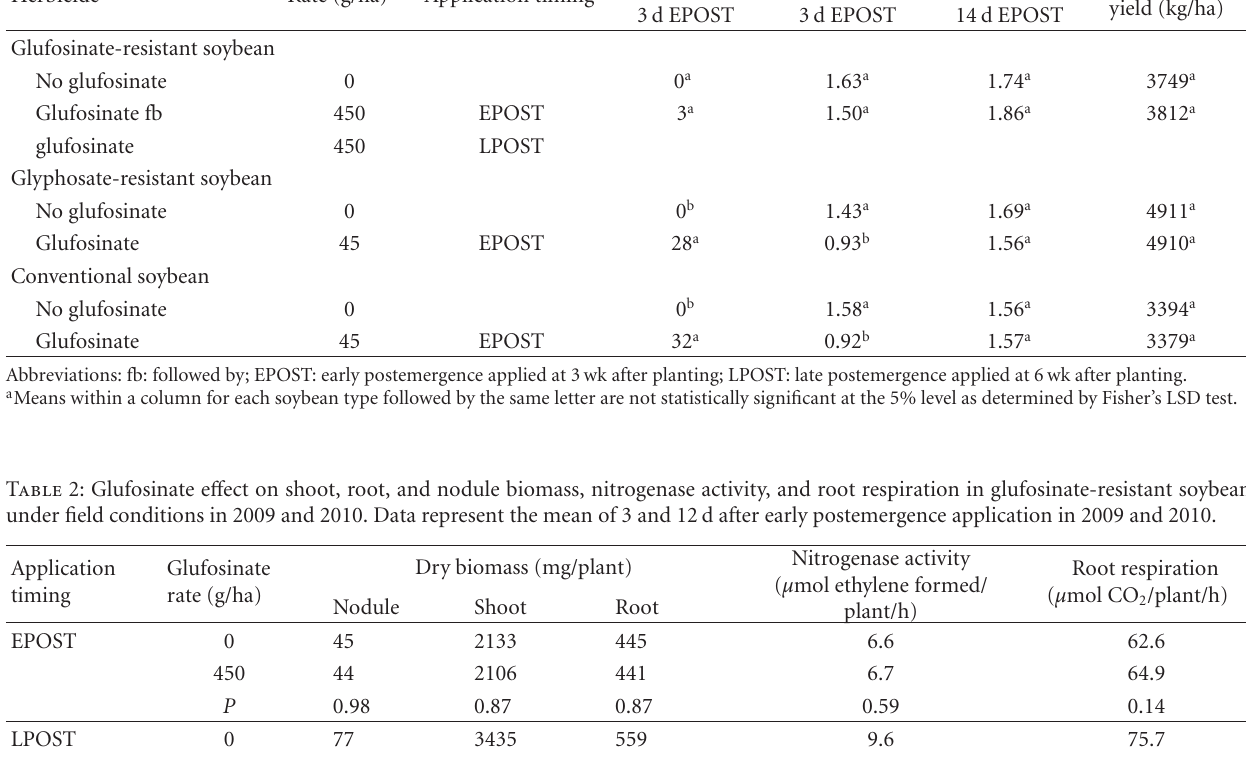
Table 1: Glufosinate e ff ect on plant injury, chlorophyll content, and yield in glufosinate-resistant, glyphosate-resistant, and conventional soybean in a field study at Stoneville, MS, 2009 and 2010 a . Herbicide Glufosinate-resistant soybean